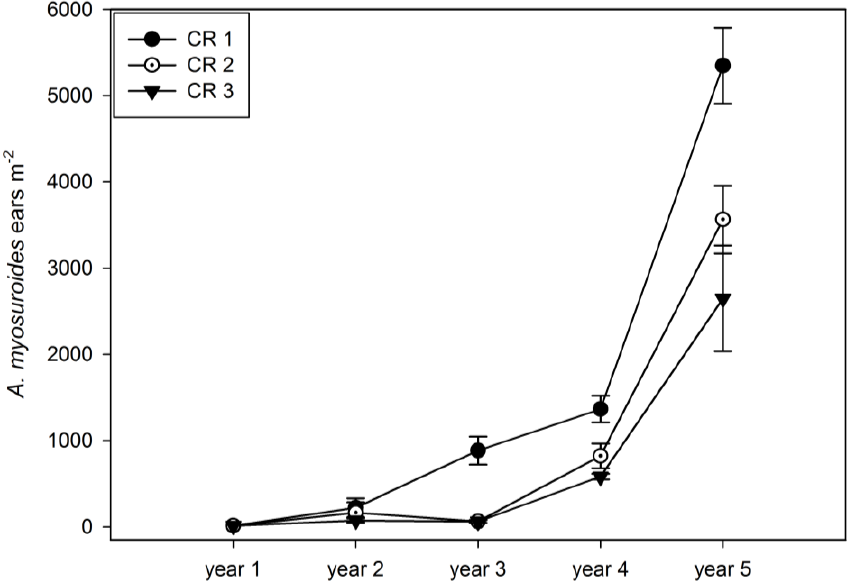
Figure 1. A. myosuroides ears m − 2 in the untreated control plots of crop rotations (CR) 1, 2 and 3 over the five-year experiment at Ihinger Hof, Renningen, Germany.